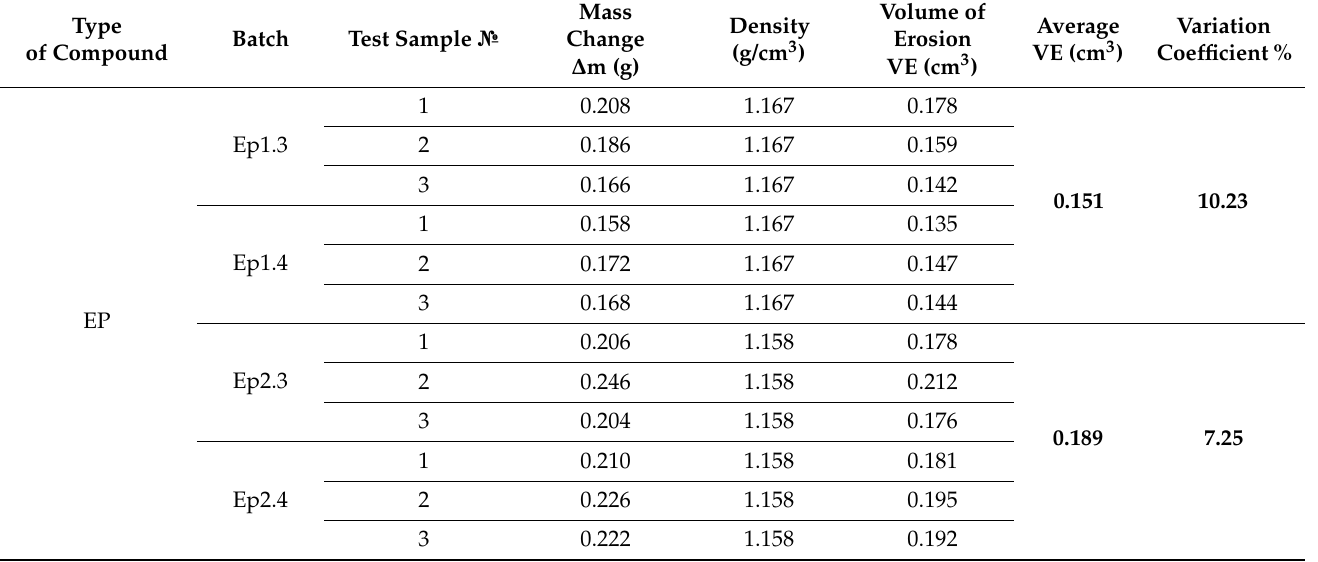
Table A4. Wear of unfilled epoxy binder (EP) at 100 ◦ C at an impingement angle of 45 ◦